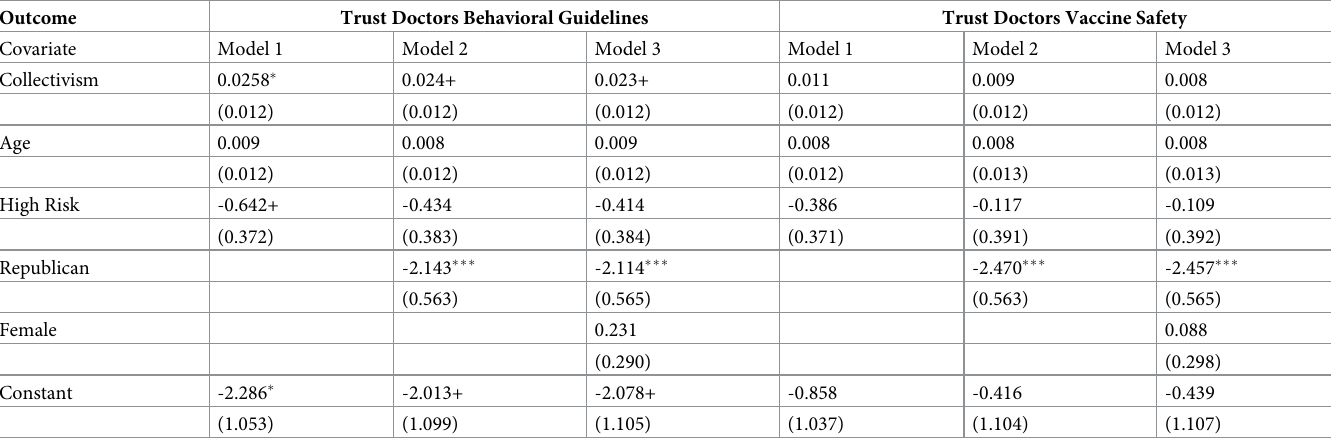
Standard errors are in parentheses. Constant represents the Y intercept.